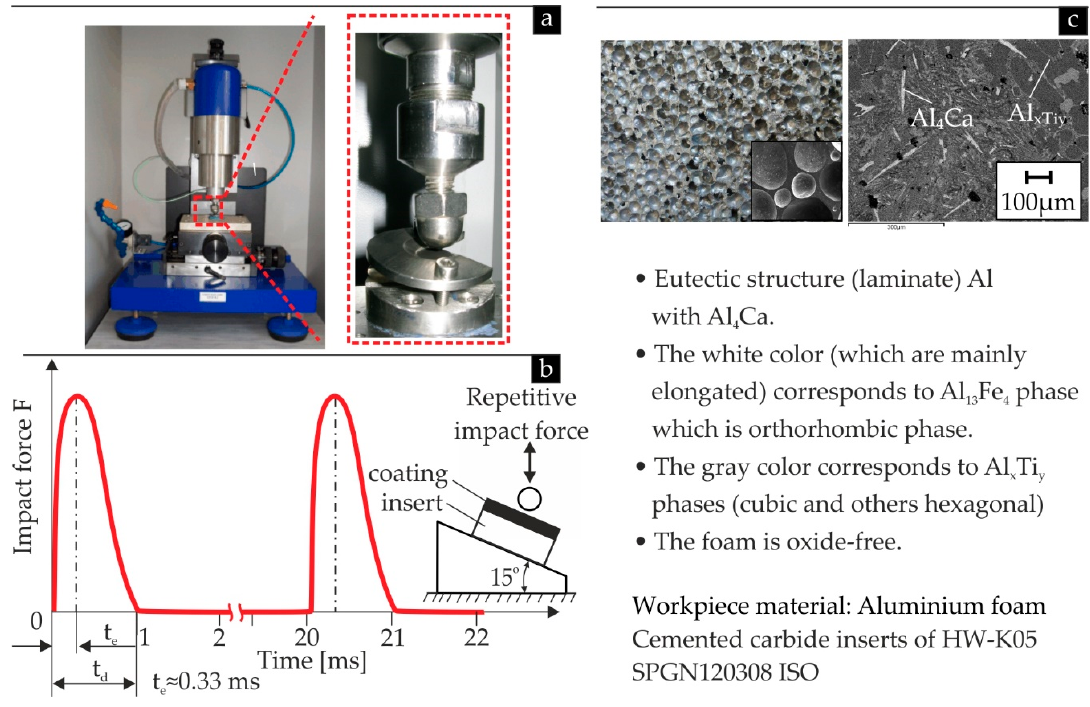
Figure 2. ( a ) The device for conducting inclined impact tests; ( b ) the applied force signals during the inclined impact test; ( c ) characteristic micro-graphs of the aluminum foam used in milling experiments.